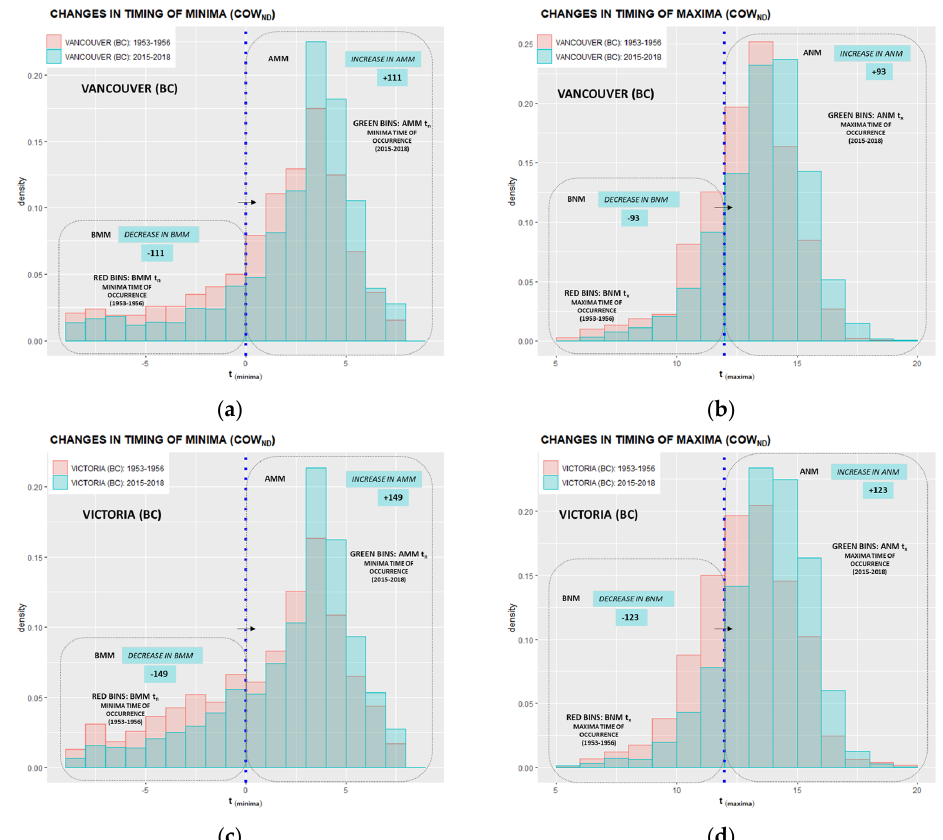
Figure A13. Pacific Coast climate region: Vancouver (BC) and Victoria (BC). Time evolution of the Diurnal Extrema Timing (DET) histograms at Vancouver ( a , b ), and Victoria ( c , d ) stations. Migration of the Before Midnight Minima (BMM) to After Midnight Minima (AMM) and migration of the Before Noon Maxima (BNM) to After Noon Maxima (ANM) between four-year averages at the beginning (1953–1956) and ending (2015–2018) of data ranges. The blue dotted line represents midnight delineation ( left ) and noon delineation ( right ).